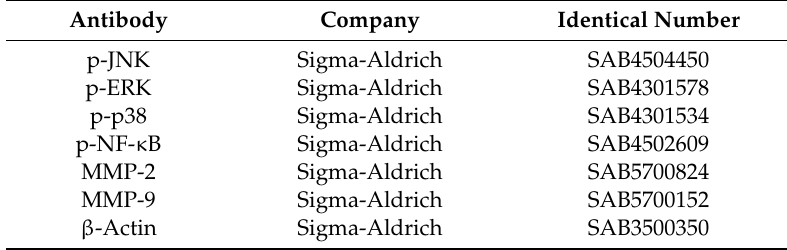
Table 2. Company and their corresponding identical numbers of the used